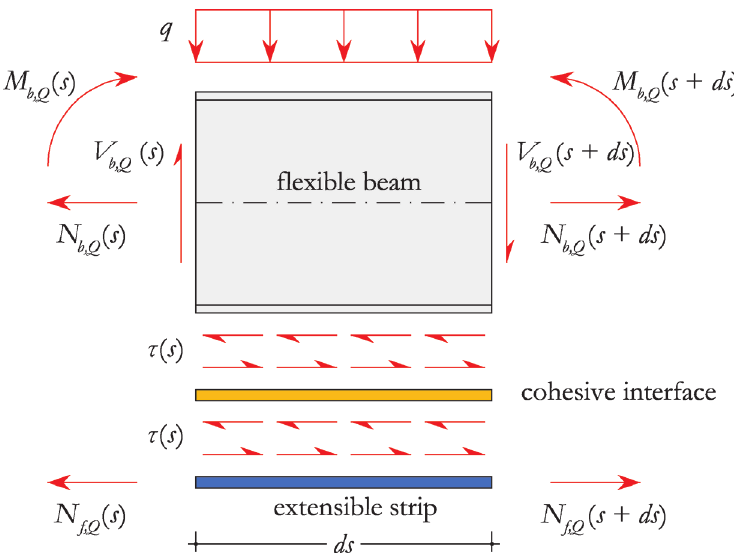
Figure 6: Free-body diagram of an elementary beam